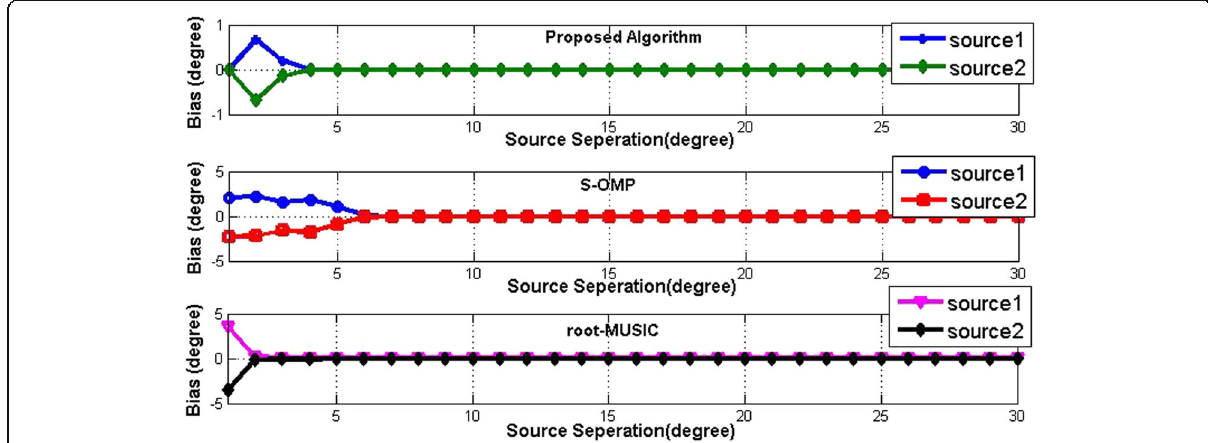
Fig. 6 Bias of localizing two sources as a function of separation for SNR = 5 dB